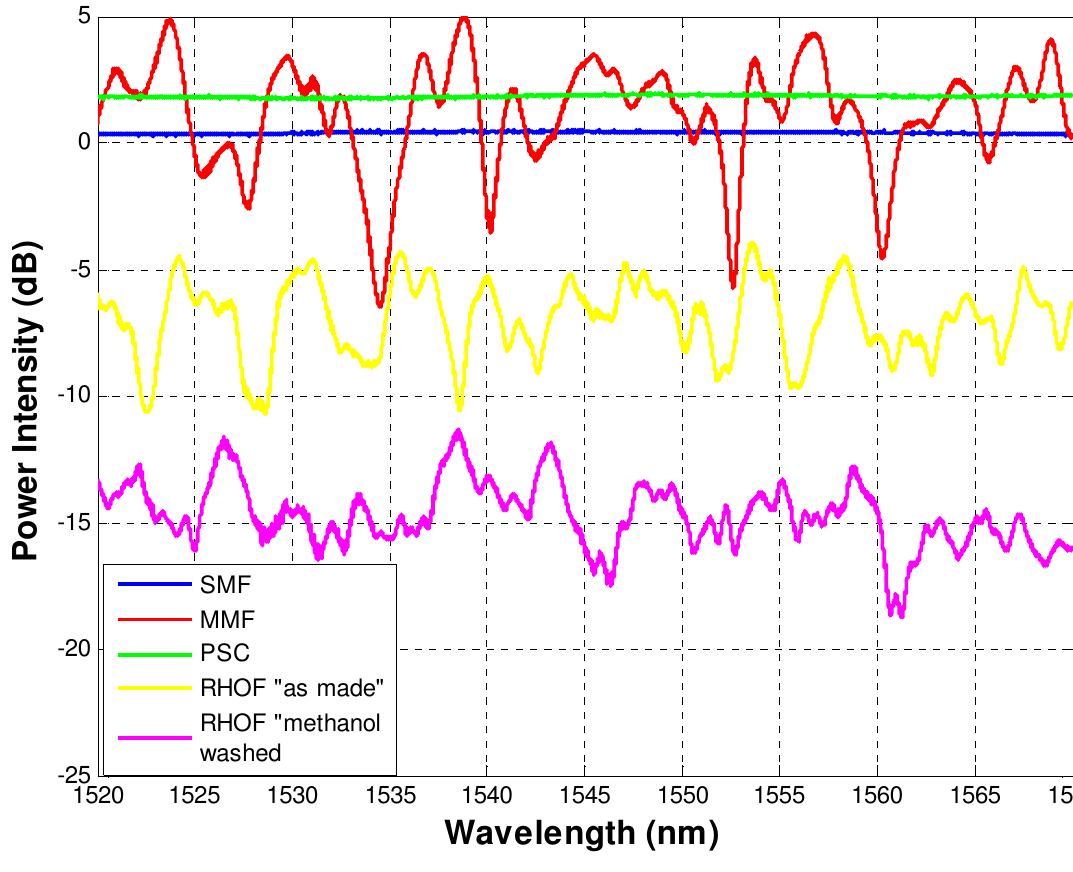
Figure 5. Transmitted optical spectra of fiber samples at t = 16 hours, SMF (blue), MMF (red), PSC (green), RHOF “as made” (yellow), RHOF “ methanol washed”